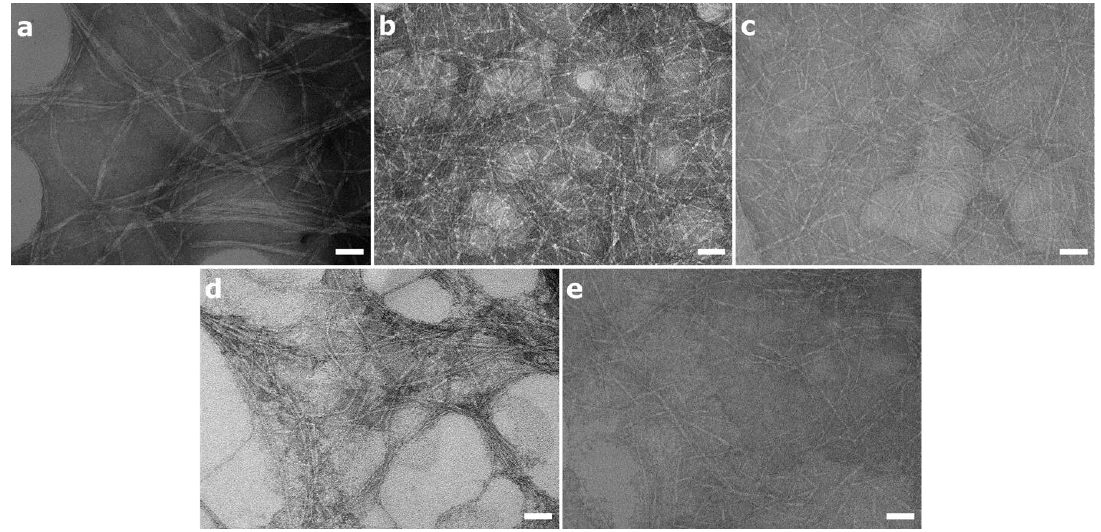
Figure 2. Representative TEM images of NFC aqueous suspensions depicting the morphology of the nanofibers. ( a ) U-NFC, ( b ) A-NFC, ( c ) C-NFC, ( d ) S-NFC and ( e ) P-NFC. Scale bars represent 50 nm.